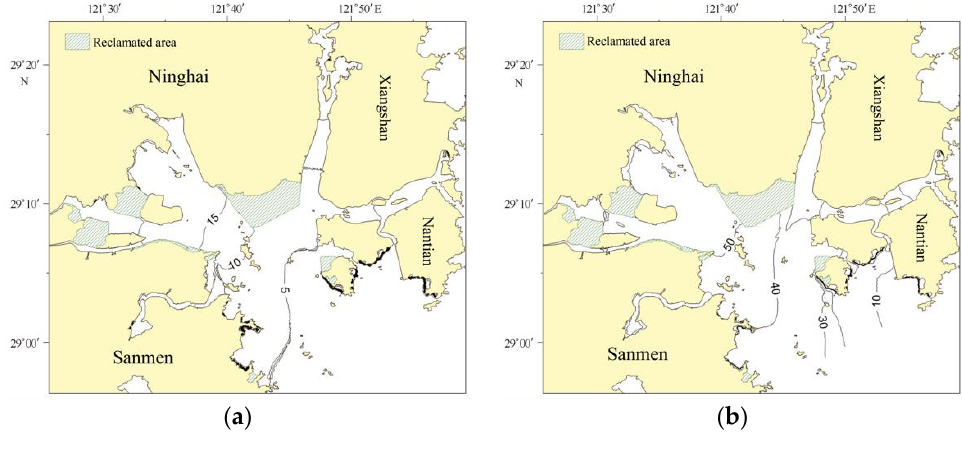
Figure 6. Water semi-exchange time ( a ) and 95% water exchange time ( b ). port in the bay head has dropped below 0.1